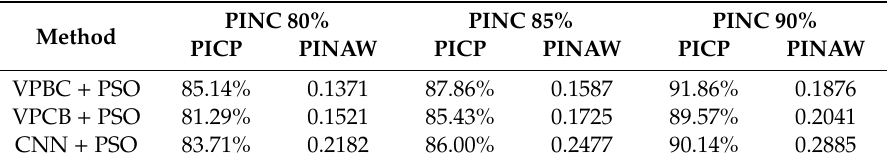
Table 2. Performance indicators for the interval forecasting of the different methods. PINC: prediction interval nominal confidence; PICP: prediction interval coverage probability; PINAW: prediction interval normalized average width.